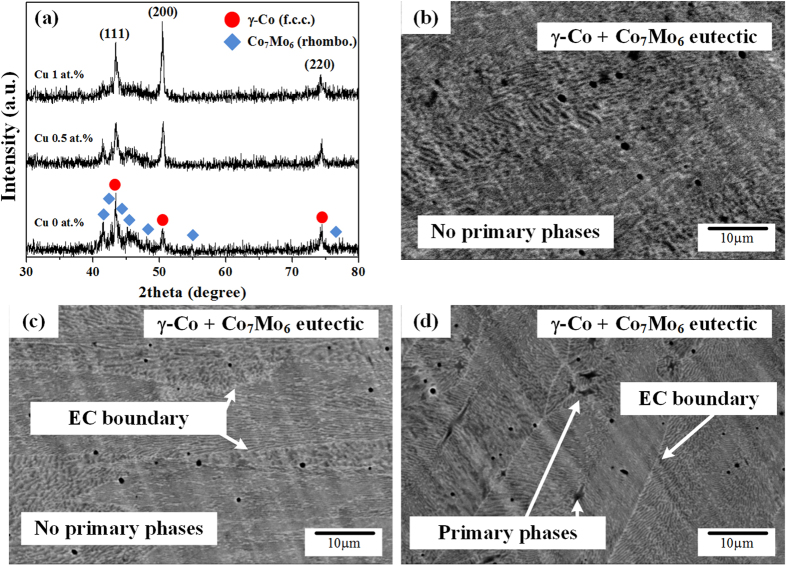
(a) XRD patterns and (b–d) SEM images obtained from the as-cast Co65−xCr13Mo22Cux alloys with x = 0, 0.5 and 1 at.%.